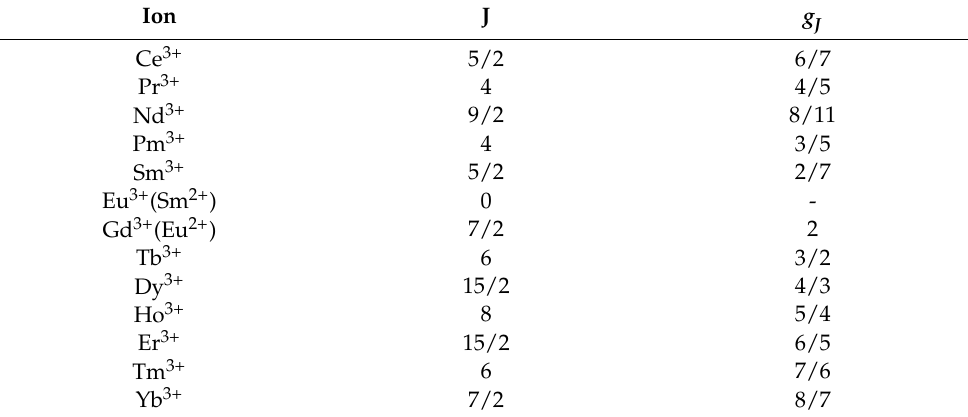
Table 1. J quantum number and Land é g-factor for lanthanoid